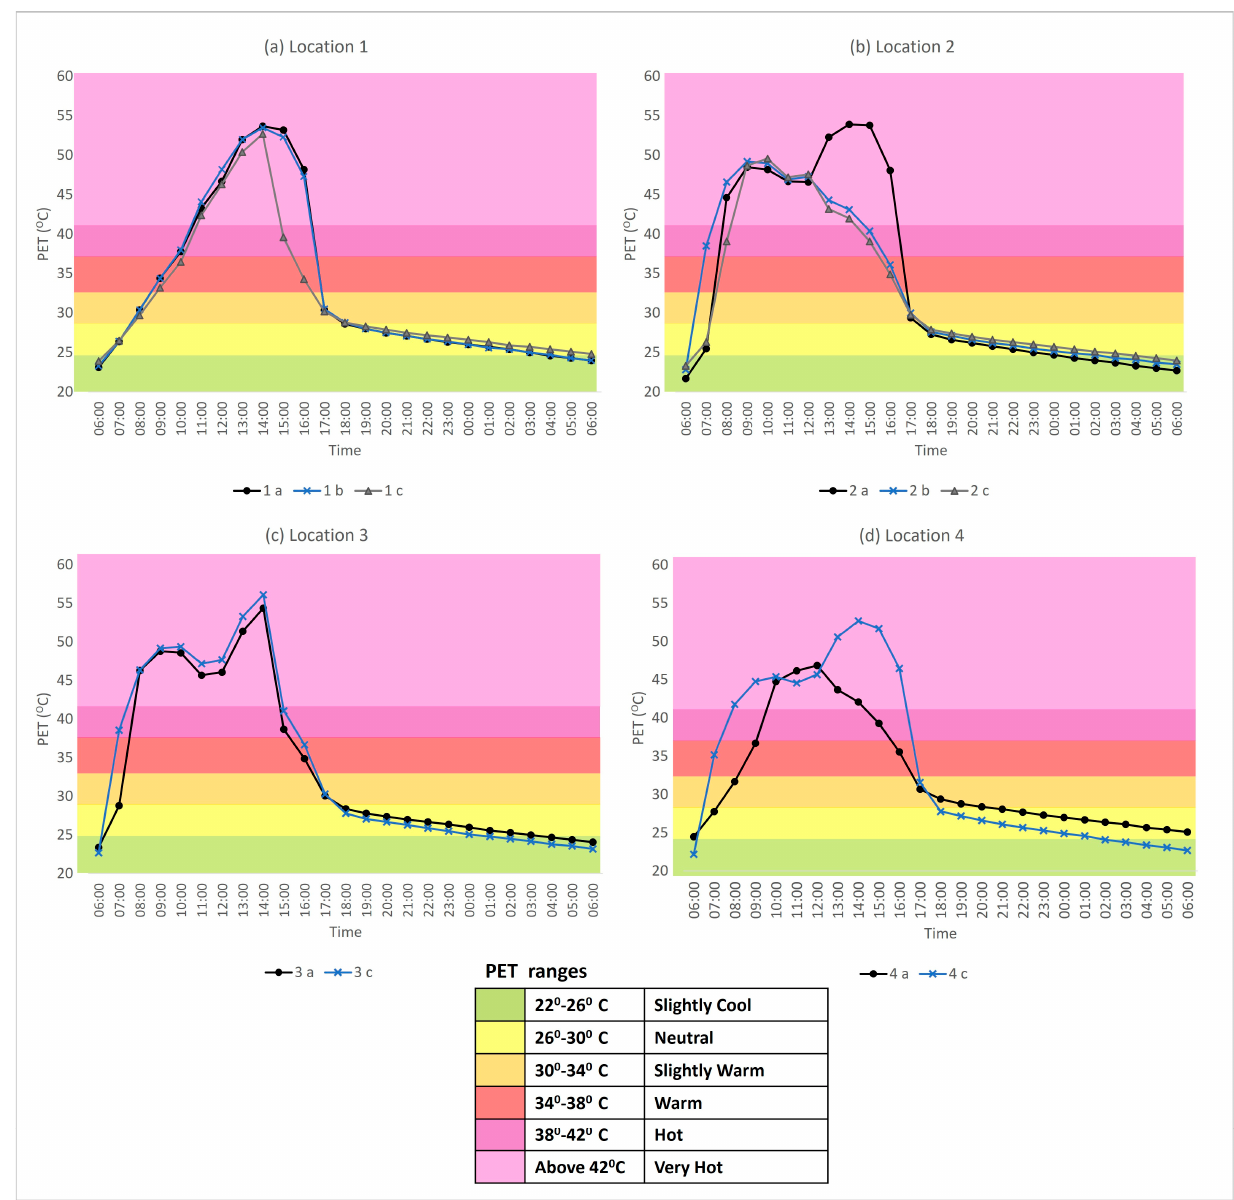
Figure 9. PET variation for the different scenarios on the simulated day.